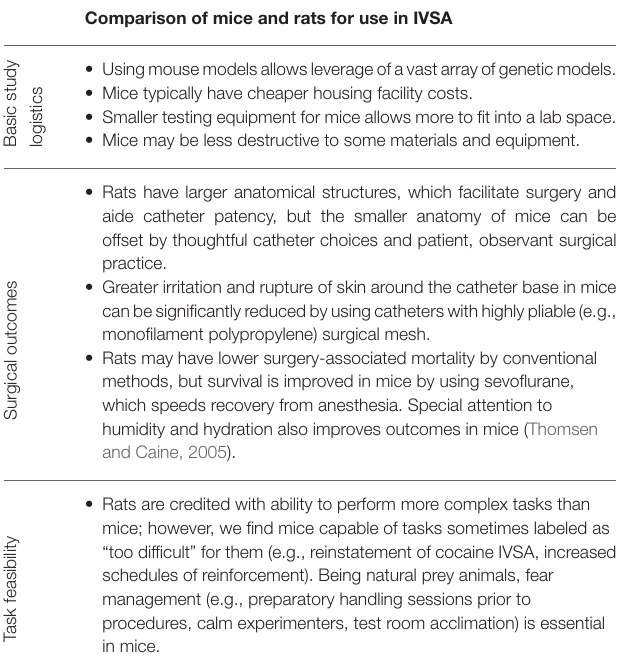
TABLE 1 | Considerations for choosing intravenous vs. oral routes of drug self-administration. Advantages and disadvantages of intravenous vs. oral drug self-administration models